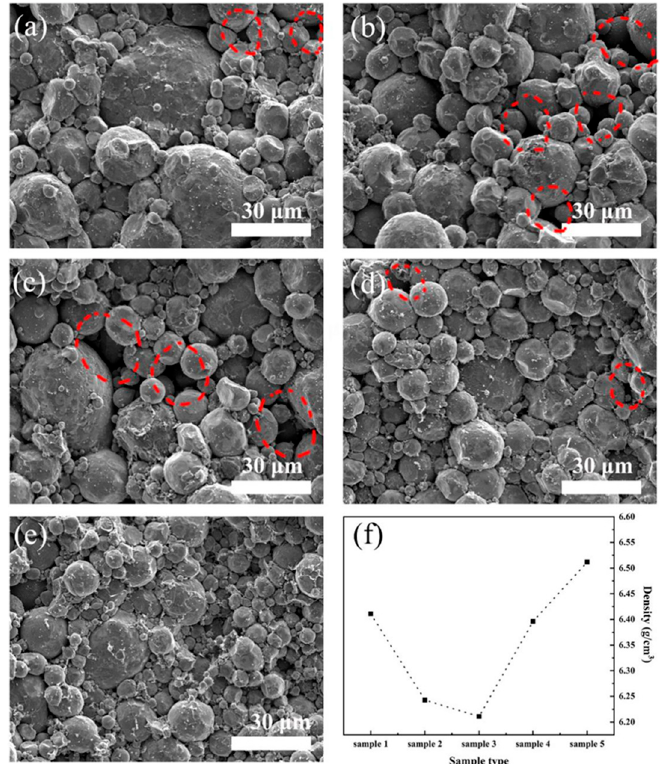
Figure 4. SEM images of fracture surface of the Fe-6.5 wt%Si SMCs with different particle size distribution, ( a – e ) represent sample 1, sample 2, sample 3, sample 4, and sample 5, respectively. In addition, ( f ) represents the density of Fe-6.5 wt%Si powder cores for samples 1–5.